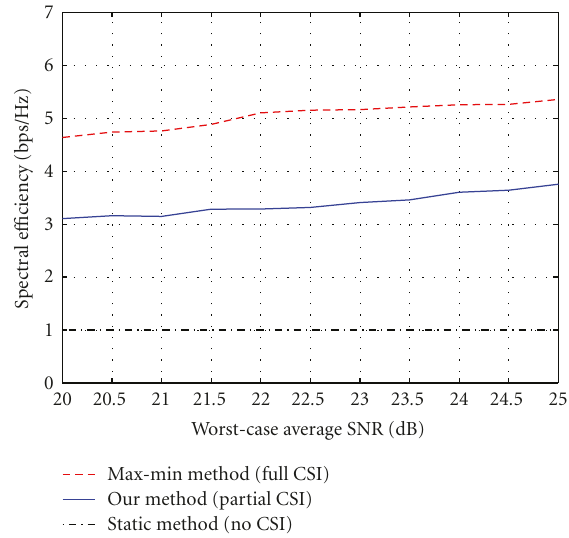
Figure 11: Average spectral e ffi ciency of our allocation method compared to the static and max-min methods for U = 10 users and R cut =